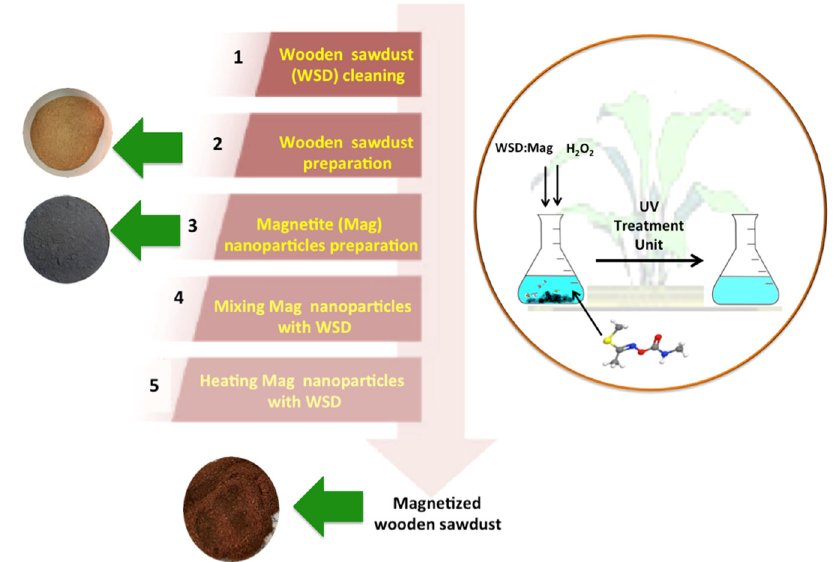
Figure 1. WSD:Mag preparation steps for becoming a